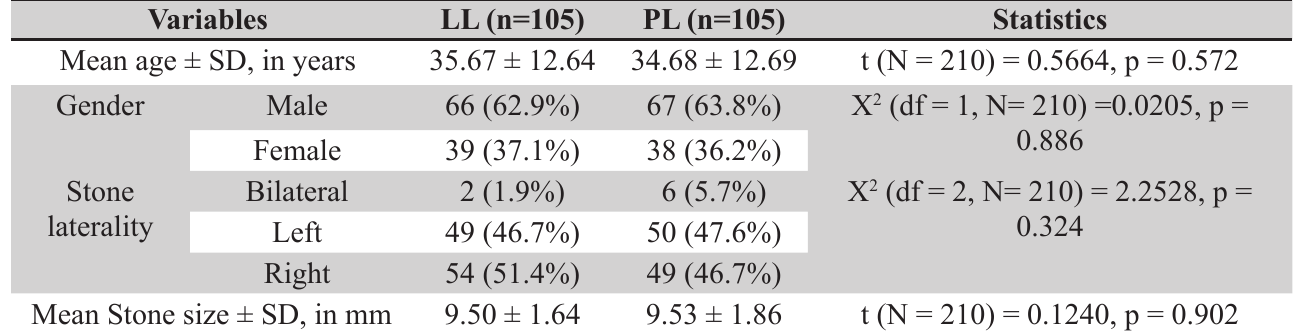
Table 1. Comparison of demographic and clinical